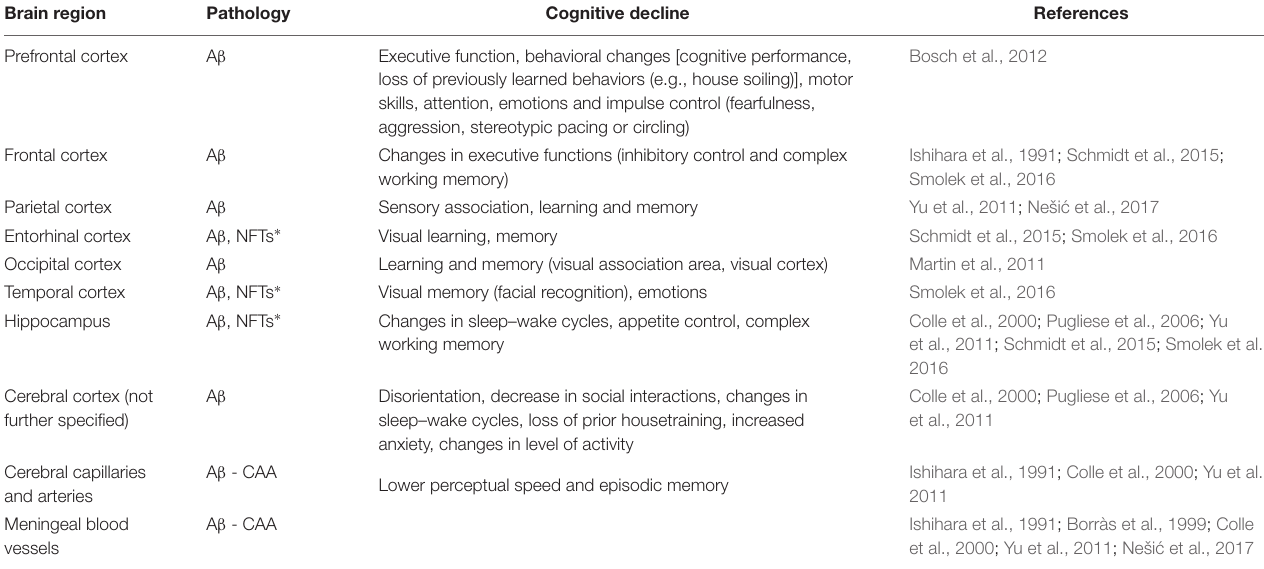
TABLE 1 | Affected brain regions and underlying cognitive deficits in